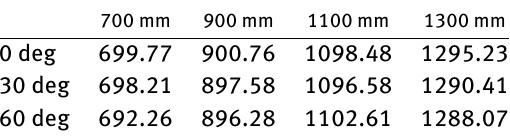
Table 1: Position average (modeled at 700